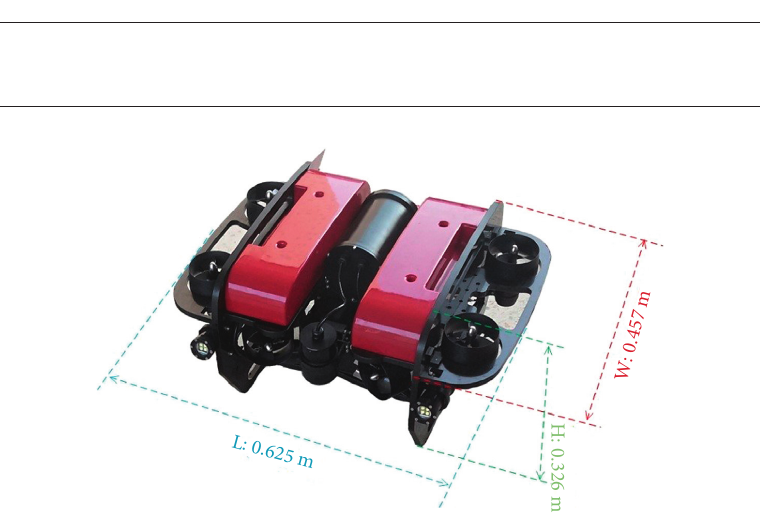
Figure 14: Underwater experiment